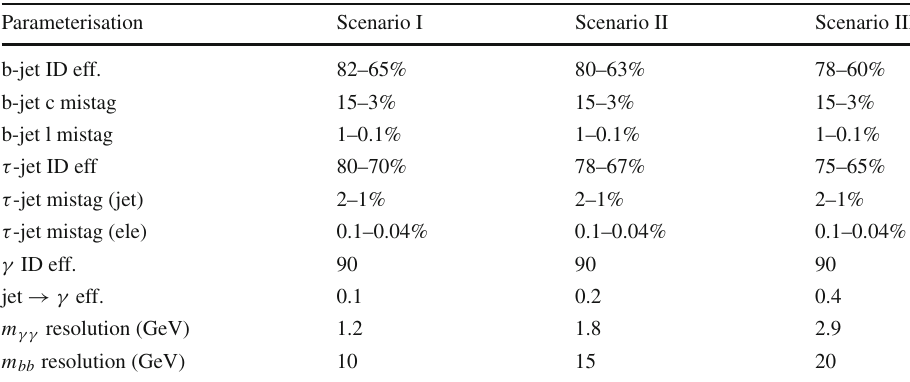
τ -jet, γ , lepton), the quoted uncertainty on reconstruction and identifi- cation efficiency is applied as many times as the object appears in the